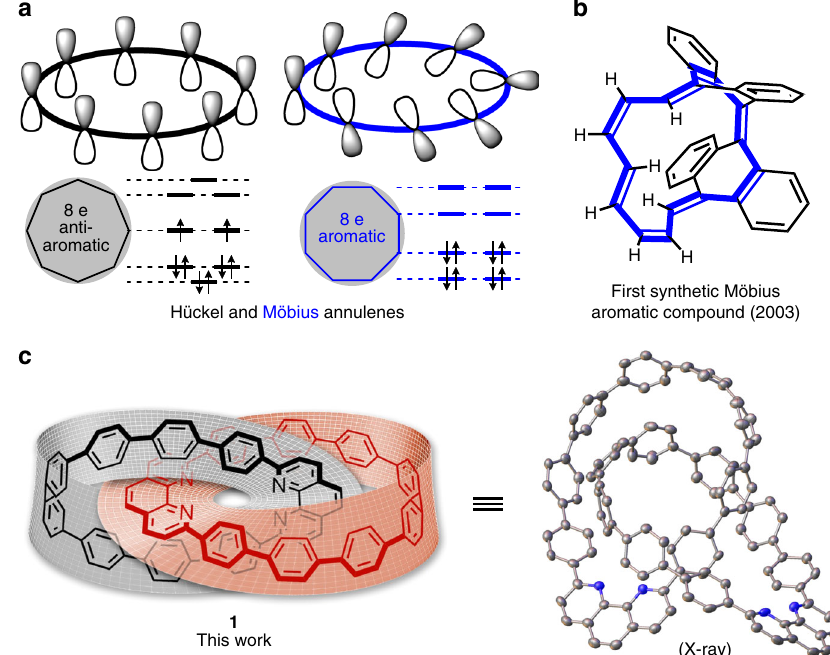
Fig. 1 Molecules exhibiting Möbius topology. a Comparison of theoretical models for Hückel and Möbius aromaticity (applied to the example of cyclooctatetraene). b Herges and co-workers prepared a polyene-derived compound that has been regarded as the fi rst isolated Möbius aromatic macrocycle. c Catenane 1 consisting of Möbius-conjugated nanohoops, with its X-ray crystal structure shown with 30%-probability ellipsoids. Hydrogen atoms and solvent molecules are omitted for